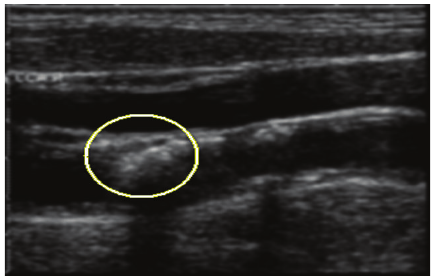
Figure 1: Carotid artery ultrasound image. The drawn ellipse marks a